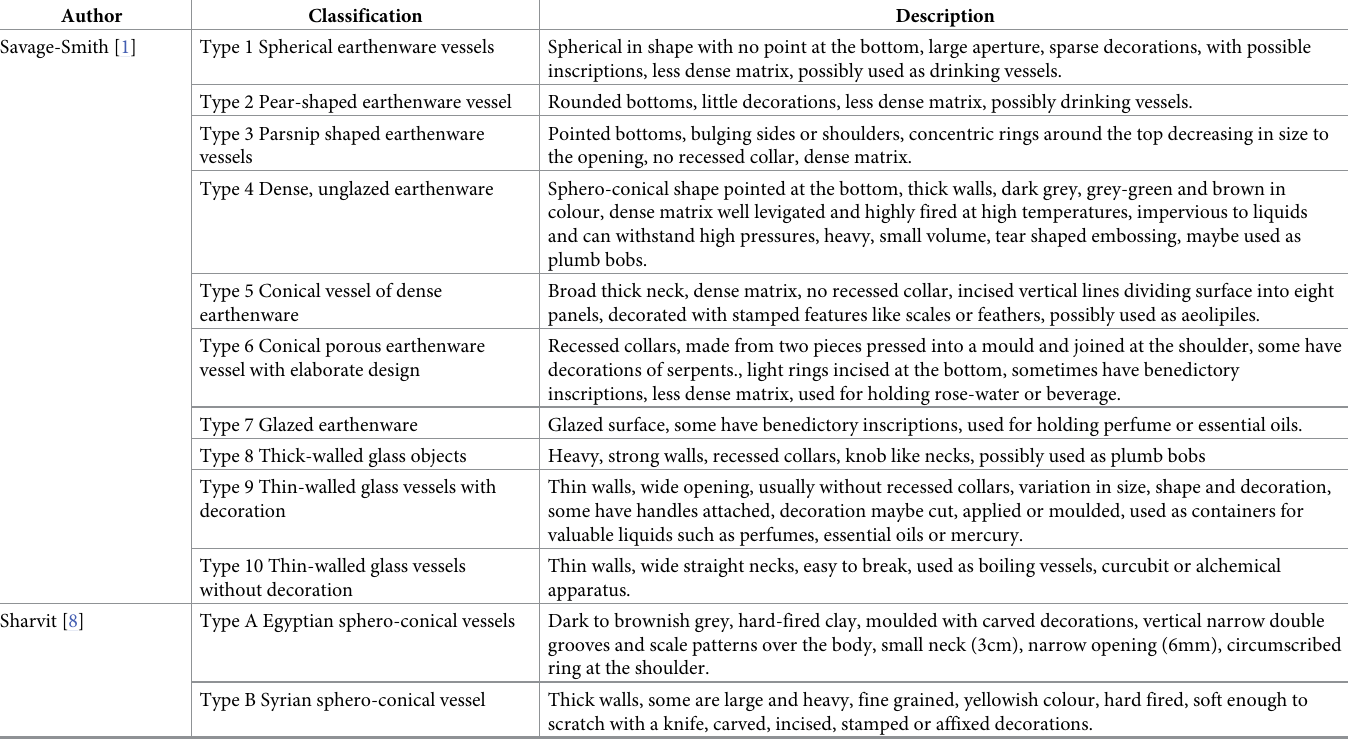
Table 1. The previous classification systems for sphero-conical